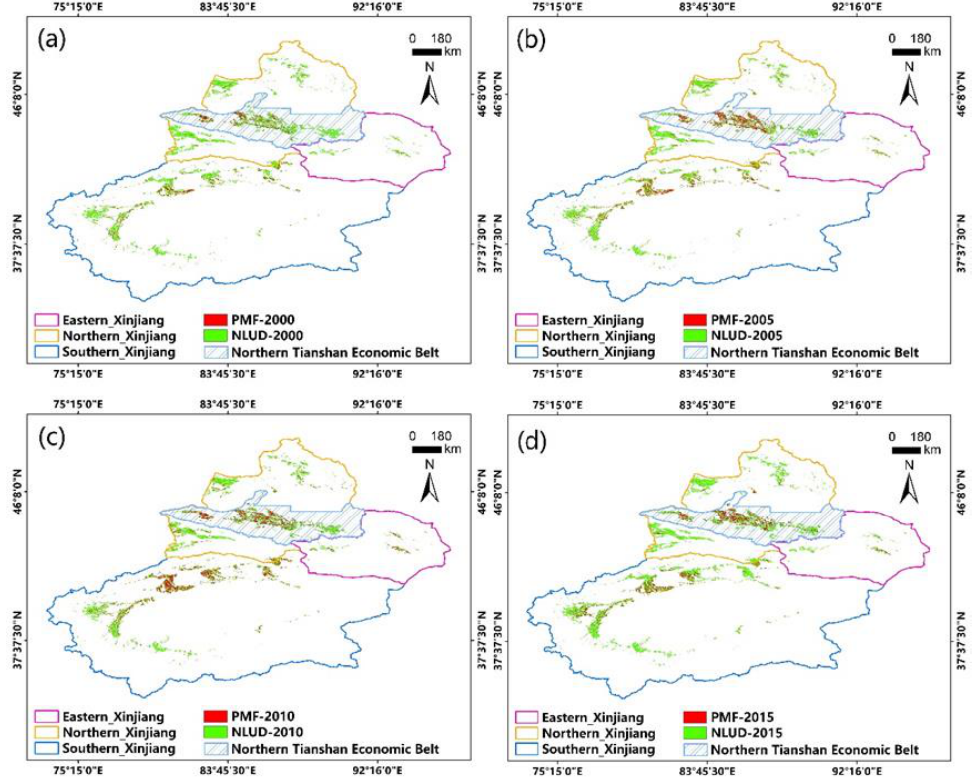
Figure 9. The spatial distribution of PMF in Xinjiang in different years (PMF extracted from PFMA).